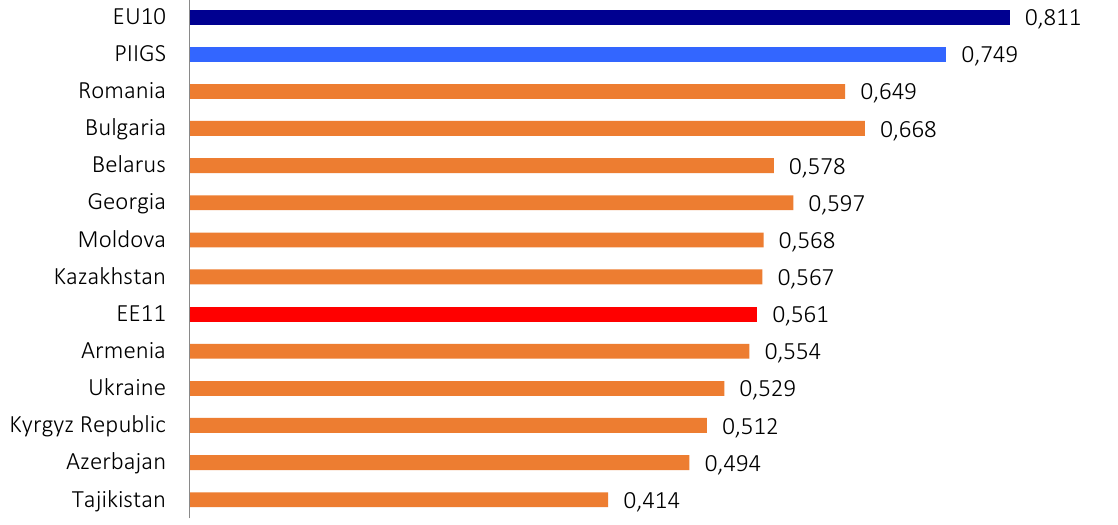
Figure 4. Integrated institutional development index y = 8,3845x + 0.9411 R² =